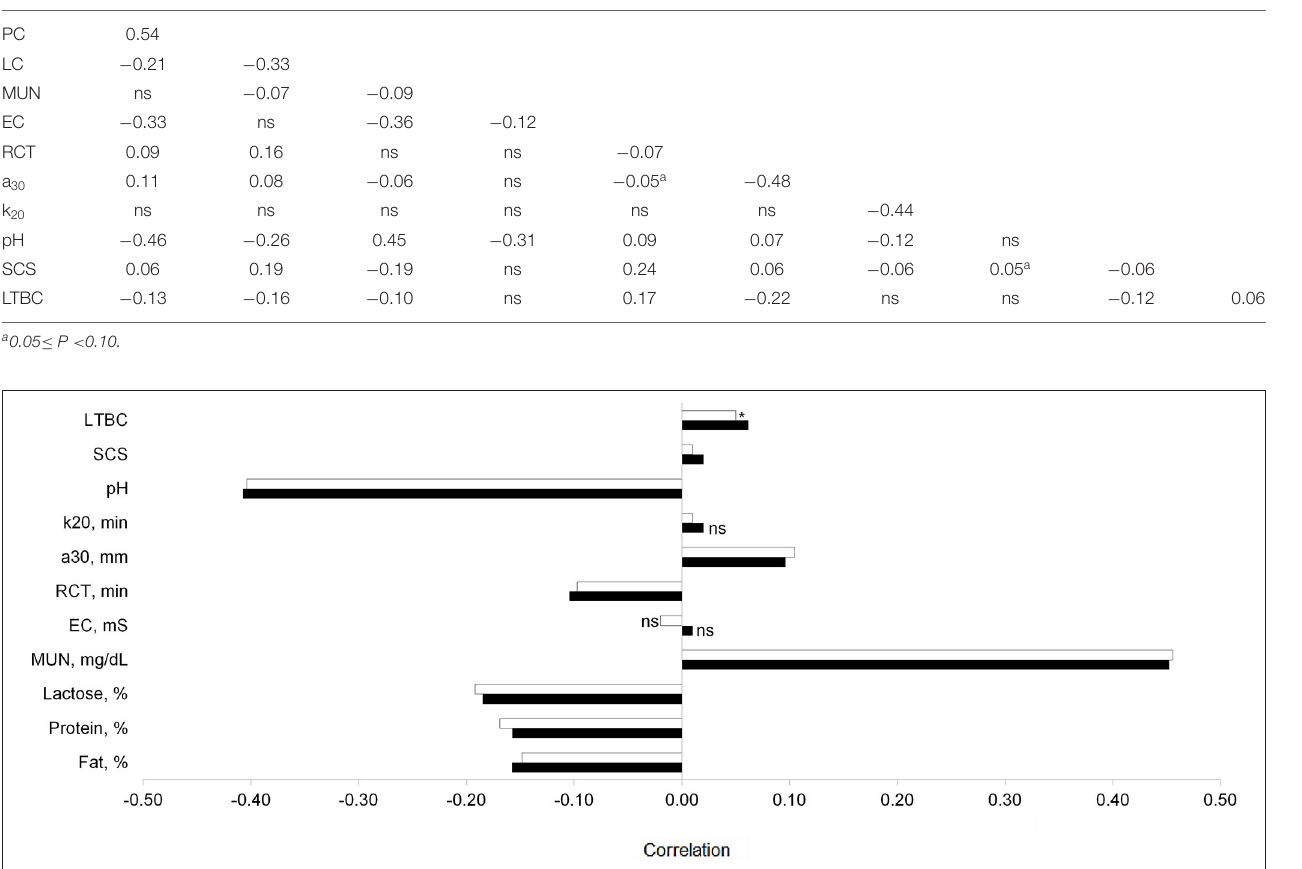
TABLE 2 | Pearson correlations ( P < 0.05) between bulk milk fat (%, FC), protein (%, PC), lactose (%, LC), urea nitrogen content (mg/dL, MUN), electrical conductivity (mS, EC), rennet coagulation time (min, RCT), curd firmness (mm, a 30 ), curd firming time (min, k 20 ), pH, somatic cell score (SCS), and log 10 of total bacteria count (LTBC). Trait